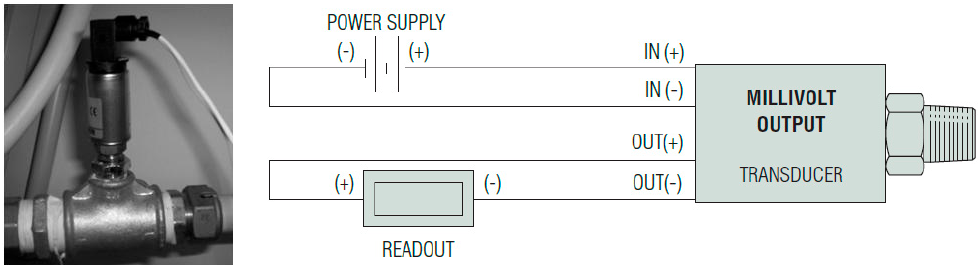
Figure 4. One of the pressure transducer/sensor (Gems 2200) located on the pipeline with its positioning ( left ) and technical features ( right ).